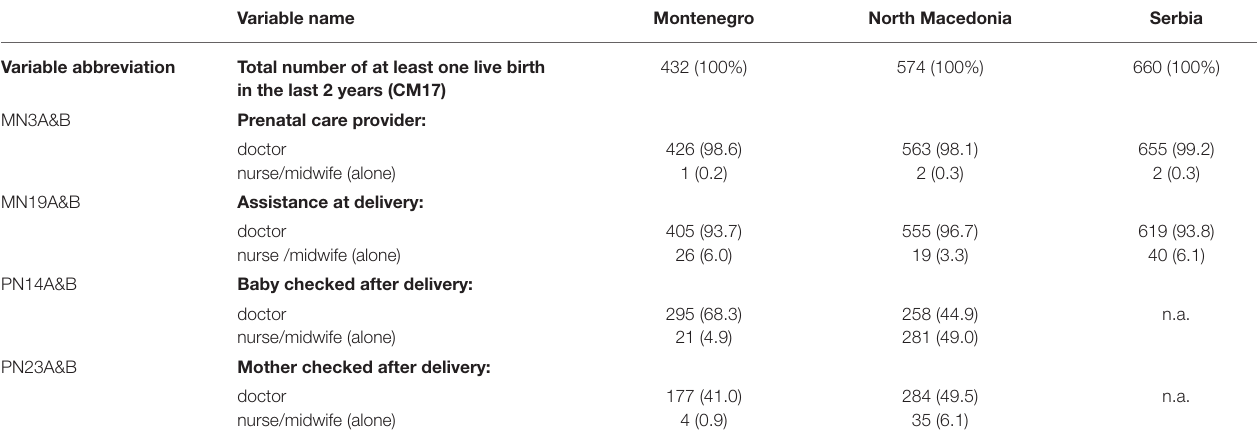
TABLE 3 | Professional assistance during